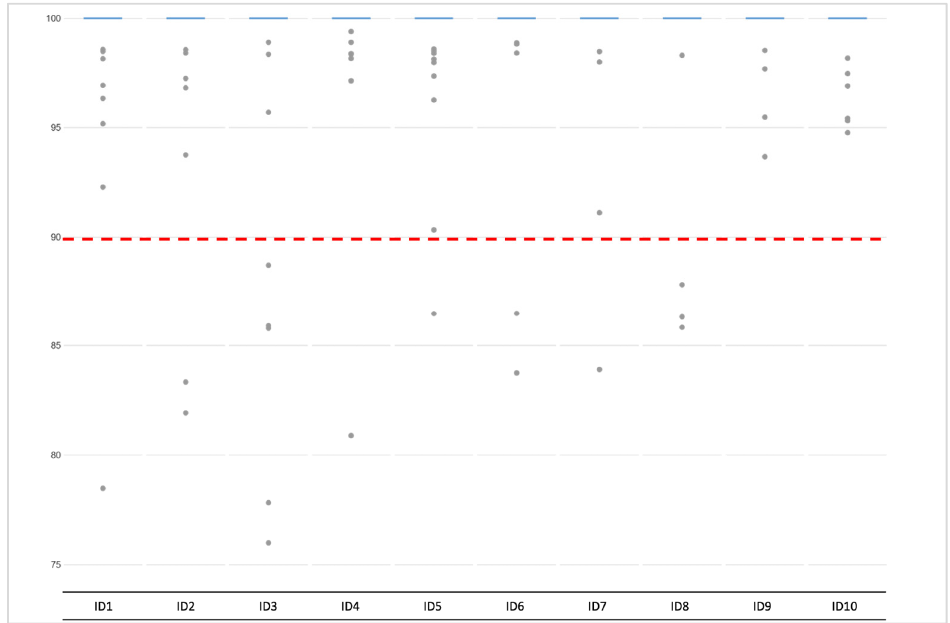
Figure 4. Allele frequency distribution across 155 homozygote loci among ten single-cell-based libraries (AMP). Grey dots represent the homozygotic loci with less than the expected 100% frequency, which is marked with blue lines. Red line corresponds to lowest (90%) accepted threshold. The minimum number of loci per sample below threshold was one; the maximum was five.